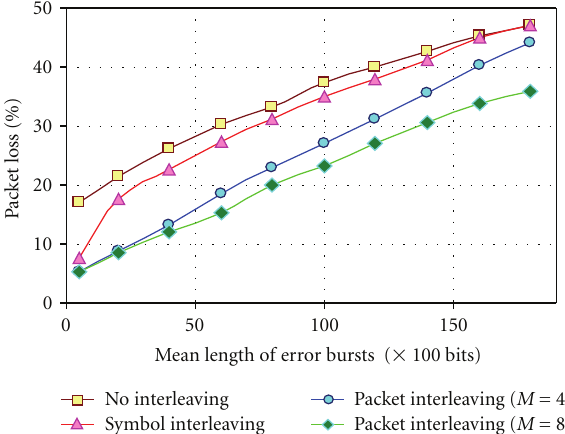
Figure 7: Packet loss after streaming the News video across a Bluetooth channel with the basic FEC interleaving scheme for two global FEC group sizes. “No Interleaving” includes built- in Bluetooth FEC, while “Symbol Interleaving” also includes bit interleaving within blocks. Both the latter schemes are at the subpacket level.